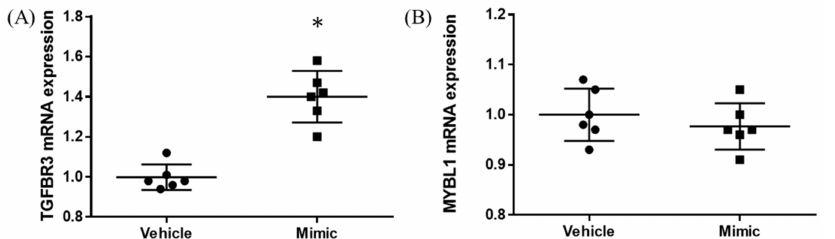
Figure 4. TGFBR3 and MYBL1 mRNA expression results from in vitro study. The y -axis represents the ratio of the relative expression value of the TGFBR3 ( A ) and MYBL1 ( B ). * p <